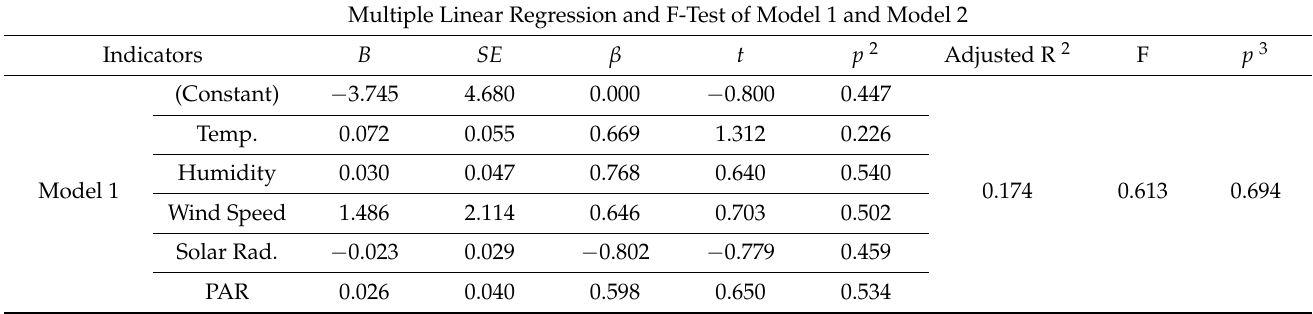
Table 6. Results of regression analysis of experimental site (700 trees/ha). Multiple Linear Regression and F-Test of Model 1 and Model